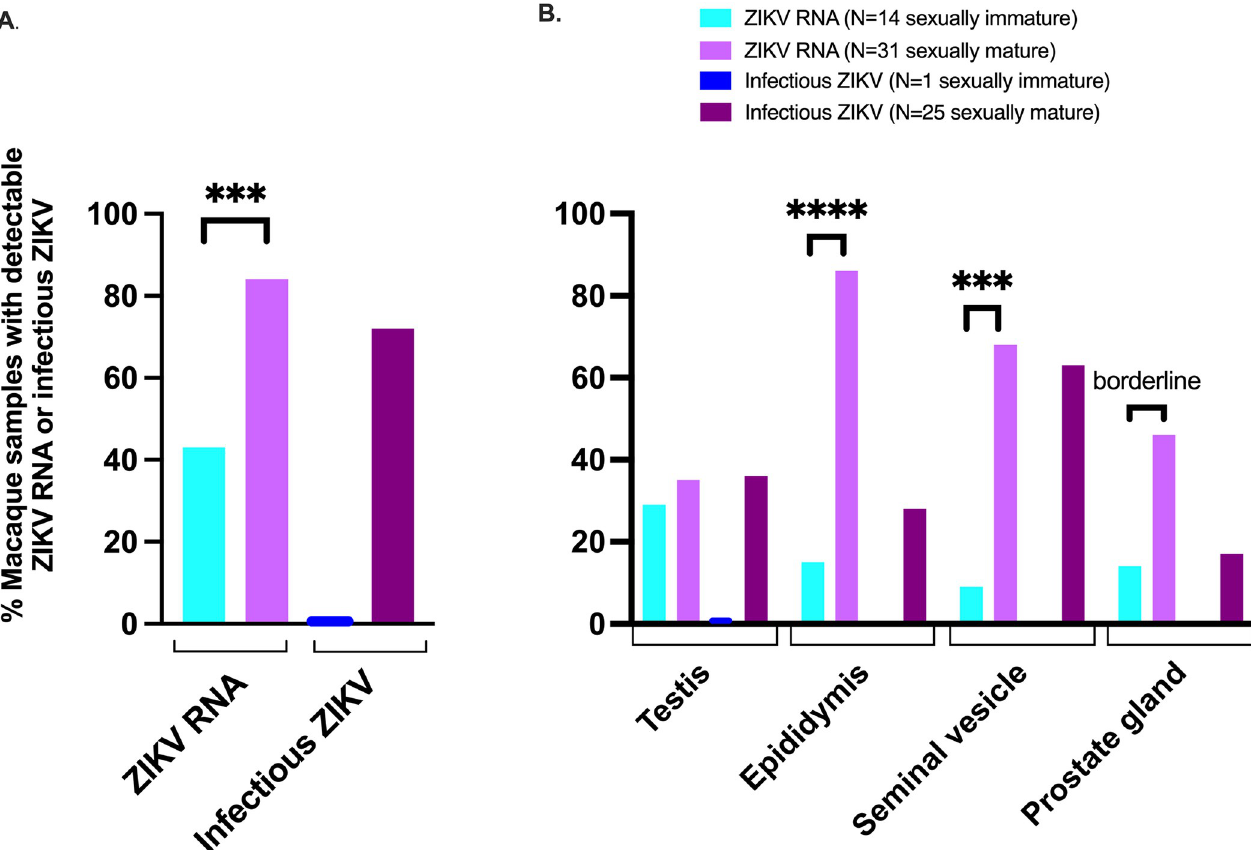
Fig 4. Sexually mature male macaques are more likely to harbor persistent ZIKV RNA and infectious virus in at least one genital tissue (A), in the epididymis and seminal vesicle (B). Only one tissue (testis) from a sexually immature macaque had detectable ZIKV RNA and no infectious virus was cultured; statistical tests were not performed on infectious ZIKV data. Sexually immature = 0–4 years old; sexually mature = > 4 years old. Logistic regression: ns, p value > 0.08; borderline, p value between 0.05 and 0.08; � , p value � 0.05; �� p value � 0.01; ��� , p value � 0.001; ���� p value � 0.0001.